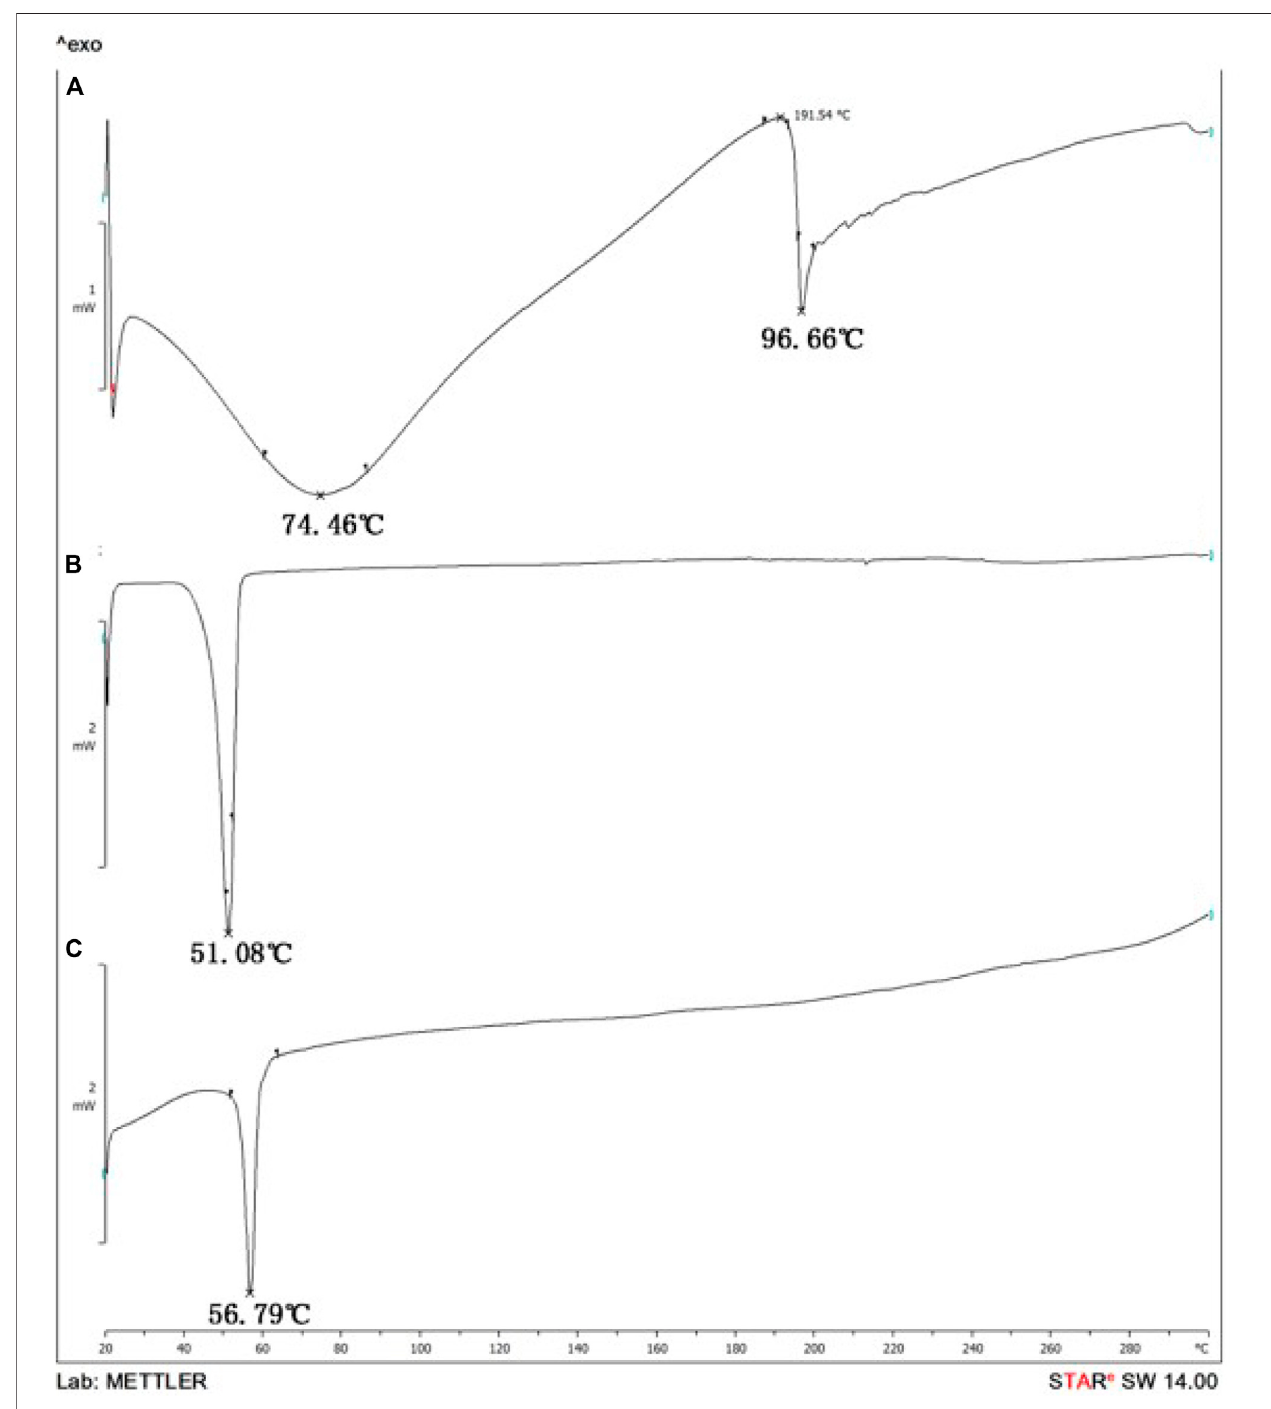
FIGURE 4 | Differential Scanning Calorimetry (DSC) spectrum: C60(OH) 22 (A) , DSPE-PEG-NH 2 (B) , and DSPE-PEG-C60 (C) .